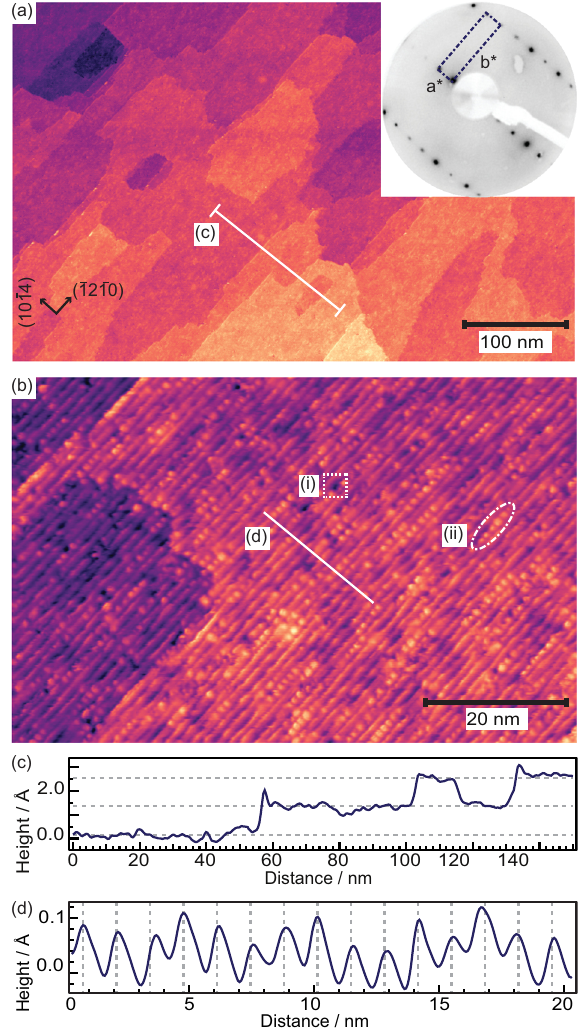
-- Fig. 1 STM characterization of the ZnO(10 14) surface. a STM image of surface prepared by annealing for 10 min at 650 ∘ C. 550 × 350 nm 2 , I = 0.2 nA, U = 1.8 V. Inset: LEED pattern of the ZnO(10 (cid:1) 14)-surface (52 eV) with the surface unit cell marked by the dashed rectangle. b STM image of the as prepared ZnO(10 (cid:1) 14) surface. 80 × 50 nm 2 , I = 0.2 nA, U = 1.8 V. Dotted squares: type (i) defects, dash-dotted ovals: type (ii) defects. c Line scan across several terraces along the line indicated ( a ). Averaged over 20 nm. Dashed lines indicate the determined average height between terraces: 1.2 Å . d Line scan perpendicular to the steps along the line indicated in b . Dashed lines indicate the average step periodicity of 13.1 Å